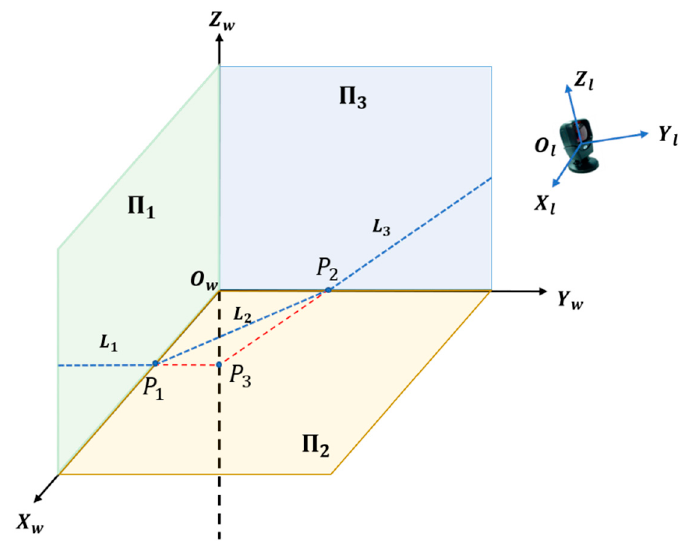
Figure 3. Schematic diagram of extrinsic calibration between the laser rangefinder (LRF) and control field.